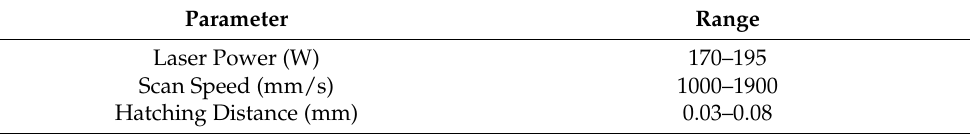
Table 1. Process parameter ranges used in the DOE, full window variation.